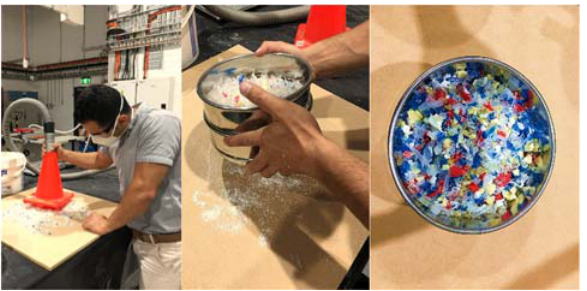
Figure 1. Separating filter fibres from biomedical polymeric waste (BPW) by sieving and vacuuming.